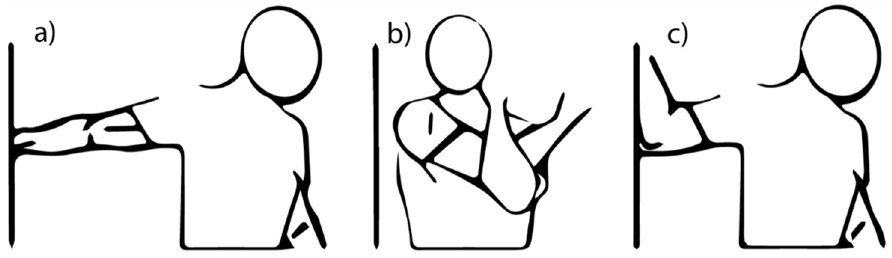
Figure 1. Stretches used as a warm-up method ( a ) shoulder, ( b ) triceps, and ( c ) pectoralis major.